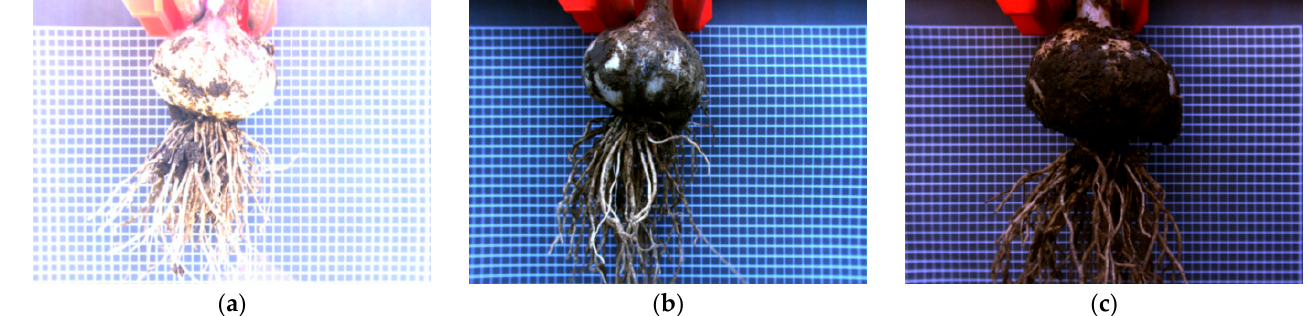
Figure 1. Diagram of brightness level differences. The average Y values are ( a ) 224.4, ( b ) 100.5, and ( c ) 58.7.